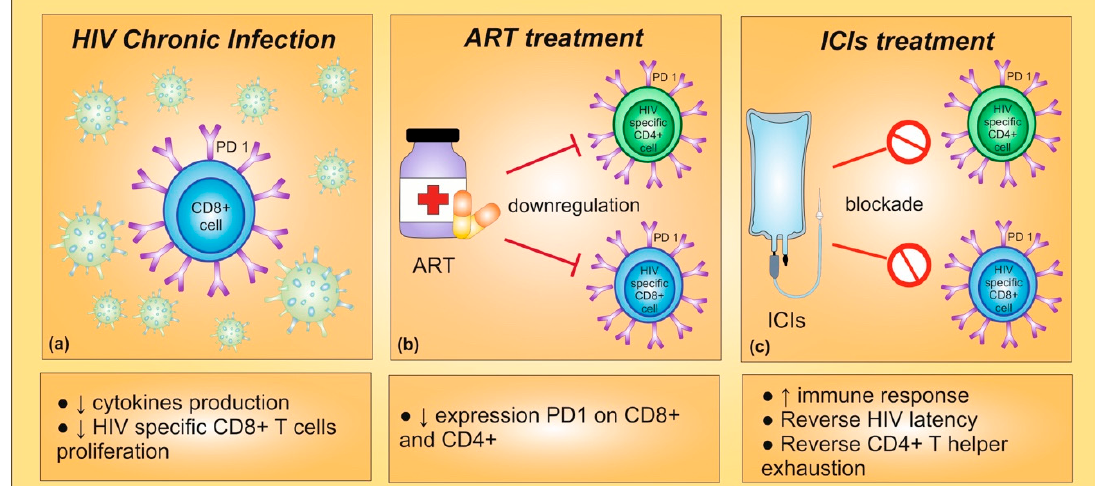
Figure 1. ( a ) During chronic HIV infection, high expression of PD-1 leads to a decrease in cytokines production and in HIV-specific CD8+ T cells proliferation. ( b ) Indeed, PD-1 expression is correlated with T cell exhaustion and disease progression in HIV-infected patients. The antiretroviral therapy (ART) seems to be able to inhibit PD-1 expression on CD8+ and CD4+ T cells. ( c ) The PD-1 blockade could provide an enhancement in CD8+ and CD4+ T cells and a restoration of the functional quality of virus-specific CD8+ T cells, improving immune response. Furthermore, immune checkpoint inhibitors could reverse HIV latency.